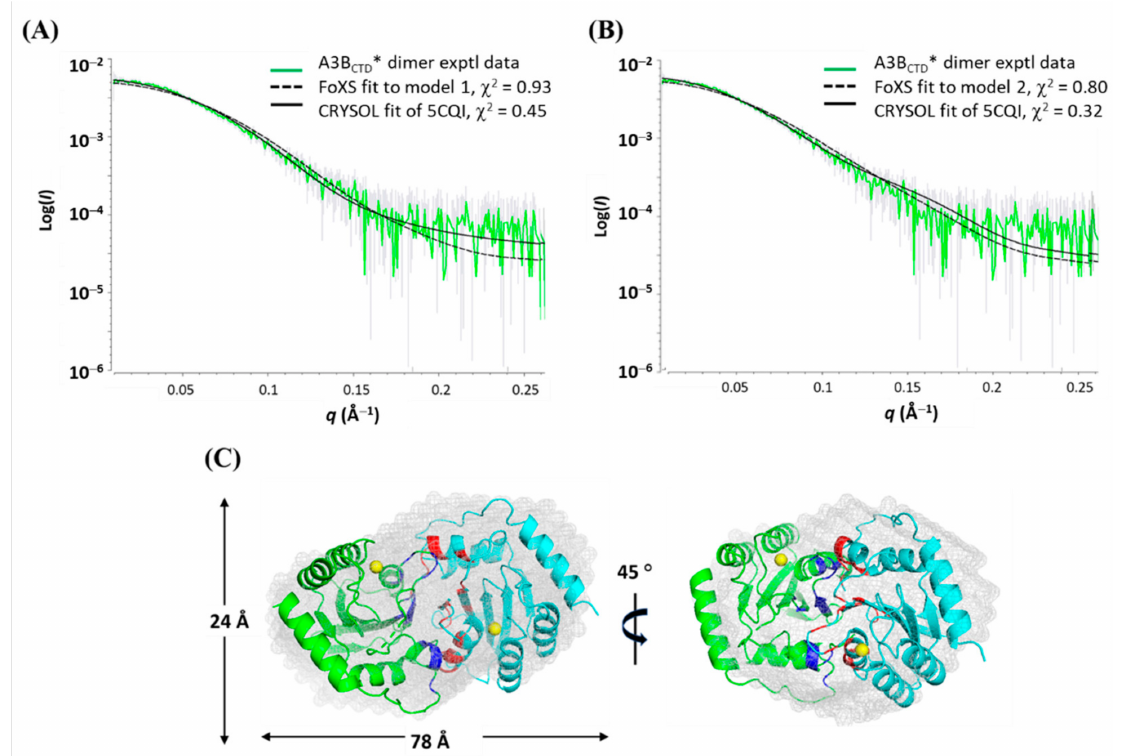
Figure 9. Fitting A3B CTD * dimer scattering data to the simulated atomic interface models. Rigid body modelling of the A3B CTD * dimer to ( A ) interface model 1 or ( B ) interface model 2 using FoXS and CRYSOL. ( C ) Model 1 interface structure fitted to the A3B CTD * dimer envelope. Averaged envelope model of A3B CTD * dimer derived using P 2 symmetry (DAMMIF, DAMAVER and DAMFILT, ATSAS 2.8.3 suite [66]) superimposed with interface model